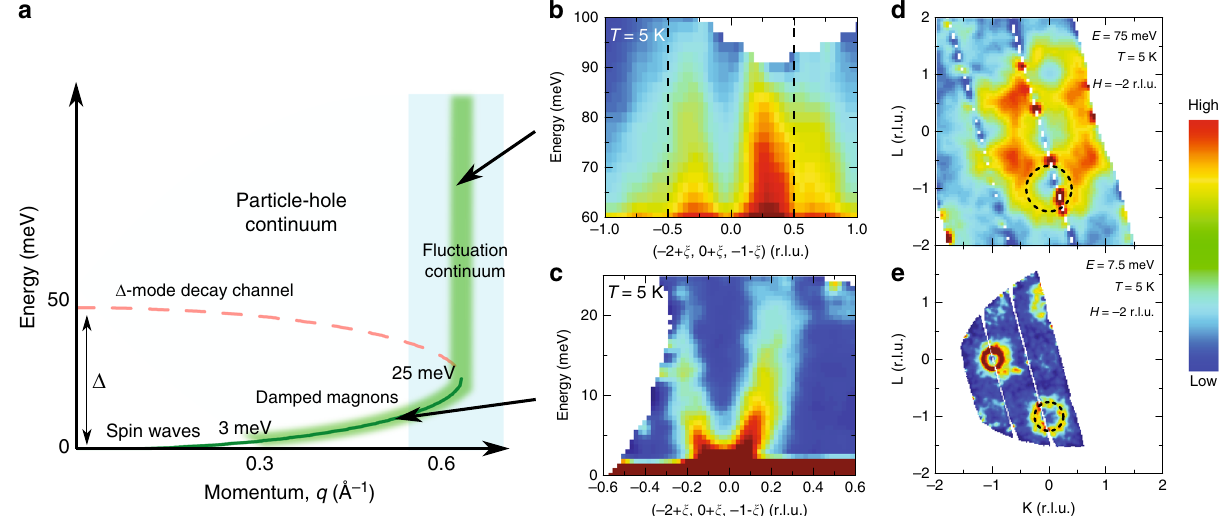
Fig. 1 Dispersion of spin fl uctuations in MnSi away from the low-q limit. a Illustration depicting low- q spin waves (green lines) entering the Stoner continuum (shaded light blue) and continuing dispersing toward the zone boundary. A second decay channel is accessed at the crossing with the Δ -mode (dashed red line) and a continuum of spin fl uctuations onsets (vertical shaded green bar). b High-energy continuum of spin excitations in MnSi collected at E = 150 meV and T = 5 K. c Low-energy dispersion of damped magnons within the Stoner continuum, collected with E i dispersion of spin excitations via constant energy slices of S ( q , Ε ) at 75 and 7.5 meV, respectively ( H is centered about H = − 2). Black dashed lines in b denote the zone boundaries at ξ = 0.5 r.l.u. Black dashed circles in d and e signal the ring-like spin wave excitation, where the radii are in line with the fi tted values from b and c and Fig. 2. The color bar denotes scattering intensity in arbitrary units with high scattering intensity in red and low scattering intensity in